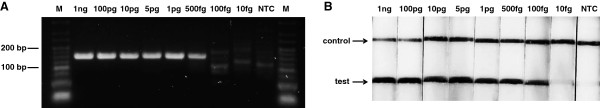
Reaction sensitivity of the recombinase polymerase amplification. A serial dilution of genomic DNA from P. falciparum 3D7 was used to test the analytical sensitivity of the assay. Positive RPA reaction products (174 bp) can be detect on a stained agarose gel (2%) (A). In the lateral flow format (LF-RPA) the sensitivity was 100 fg of genomic DNA (B). NTC: no template controls contained water.